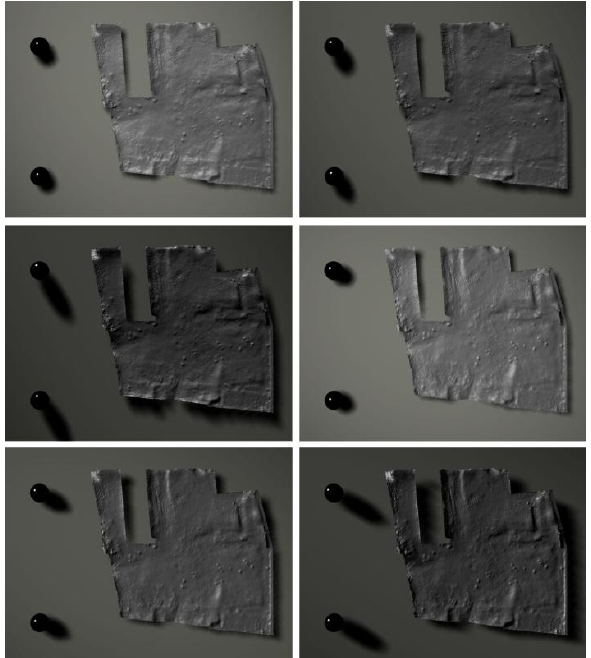
Figure 5: Images Collection obtained from 3DMax modeling software for posprocessing under Shape from Shading technique with automatic highlight calculation